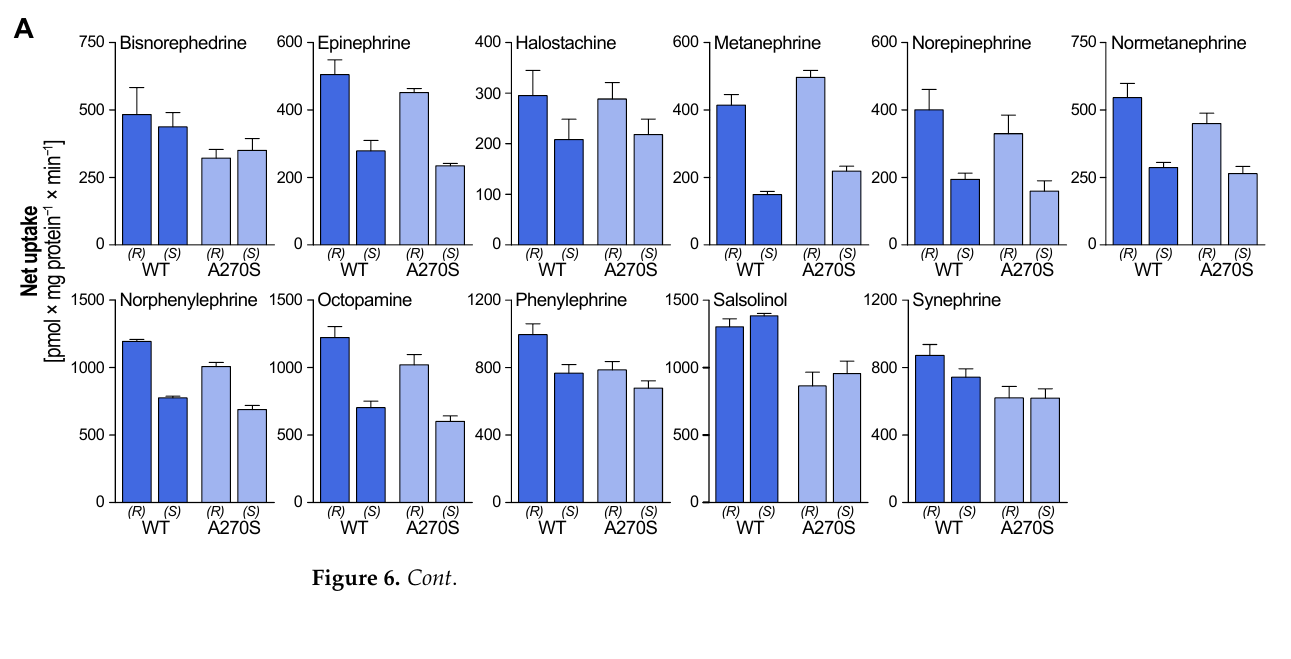
Figure 5. Analysis of stereoselectivity in the kinetic parameters K m , v max and Cl int . Kinetic con- stants of the (R) -enantiomer uptake are shown on the ordinate whereas kinetic constants of the (S) -enantiomer are shown on the abscissa. The bisections are highlighted by the dashed lines, and stereoselectivity is indicated by how strongly each point deviates from these bisections. Since OCT2 showed high uptake of all investigated compounds combined with a comparably strong stereoselectivity, we further tested whether the common A270S poly- morphism affected uptake and selectivity (Figure 6A). In many human populations, this is the only non-synonymous OCT2 variant with functional impact and a reasonable popula- tion frequency.